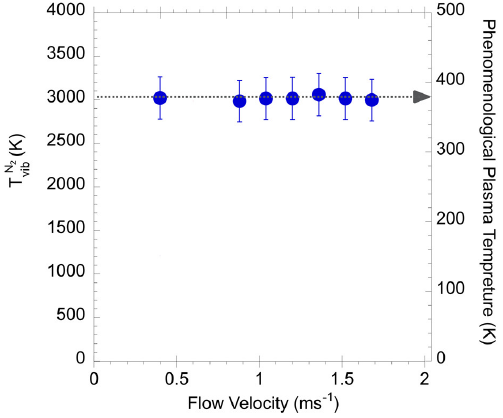
Figure 9. The    and the PPT as a function of the air velocity from 0 to 1.6 m∙s −1 .